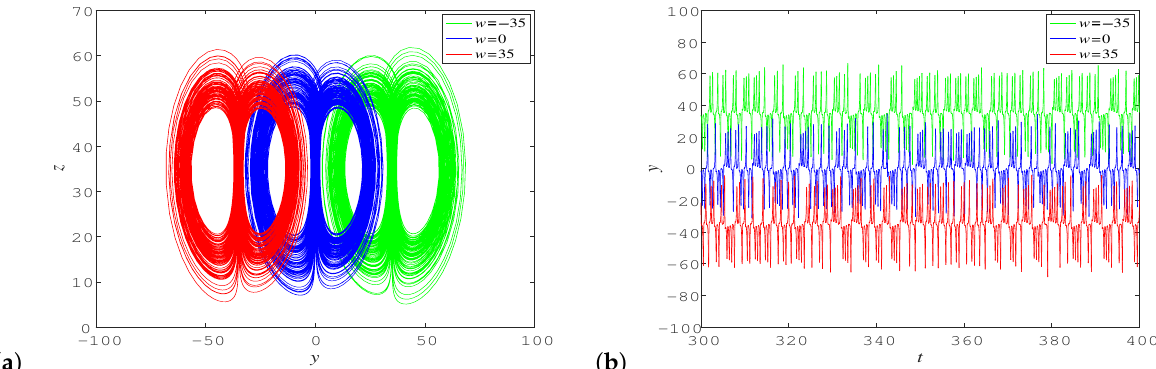
Figure 11. Offset boosting of chaotic attractor when varying control parameter w for ( a , b , c , d ) = ( 35,3,35,10 ) : ( a ) in y − z plane and ( b ) state y with different values of the offset boosting controller w . All computed for initial values ( 1,1,1 )